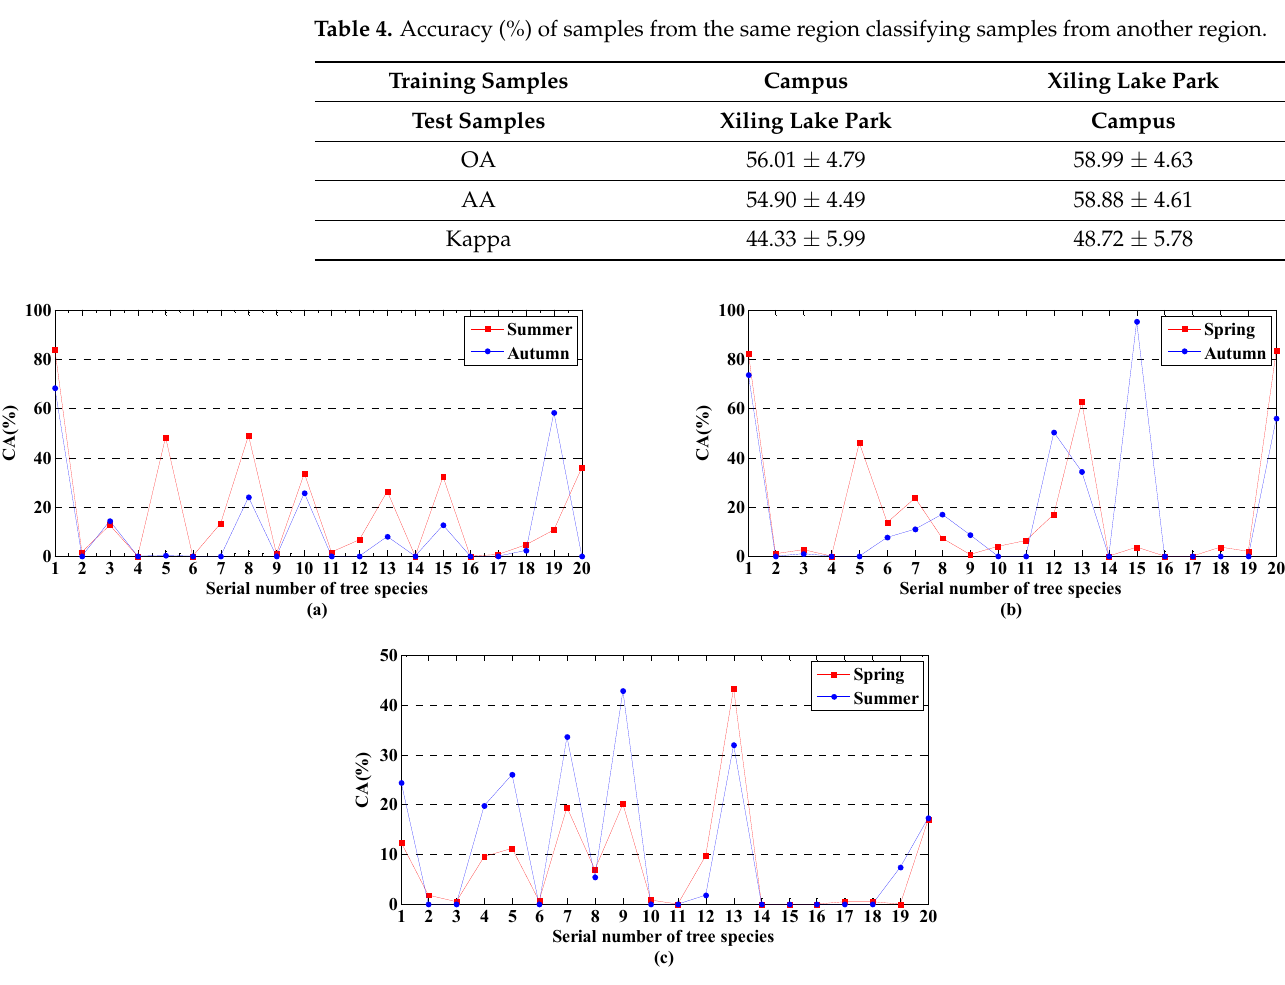
Figure 11. Class accuracy (%) of ( a ) spring samples classifying summer and autumn samples, ( b ) summer samples classifying spring and autumn samples, and ( c ) autumn samples classifying spring and summer samples.